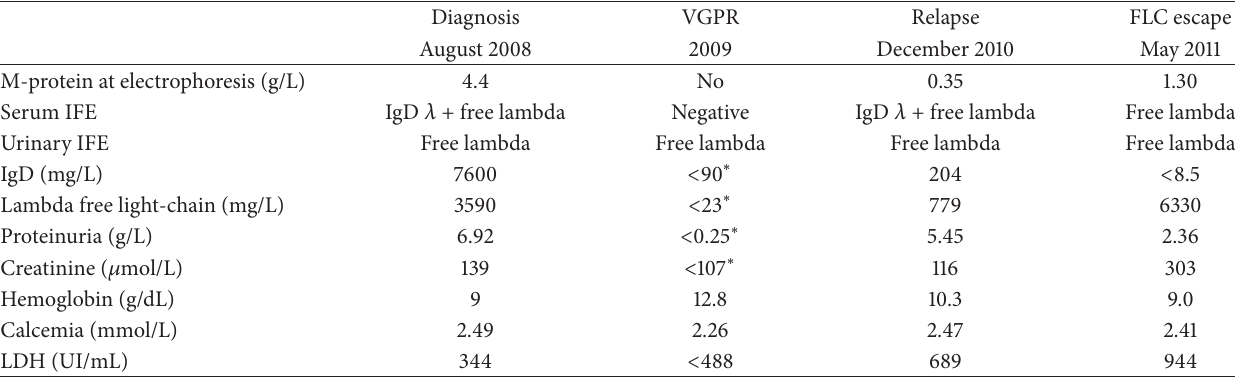
Table 1: Biochemical characteristics of the patient.